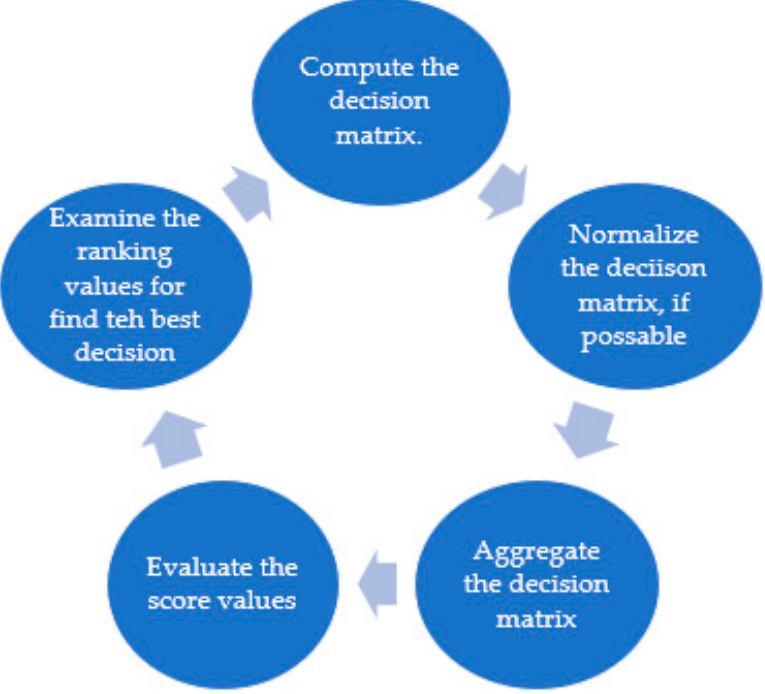
Figure 2. Geometrical representation of the proposed decision-making procedure.